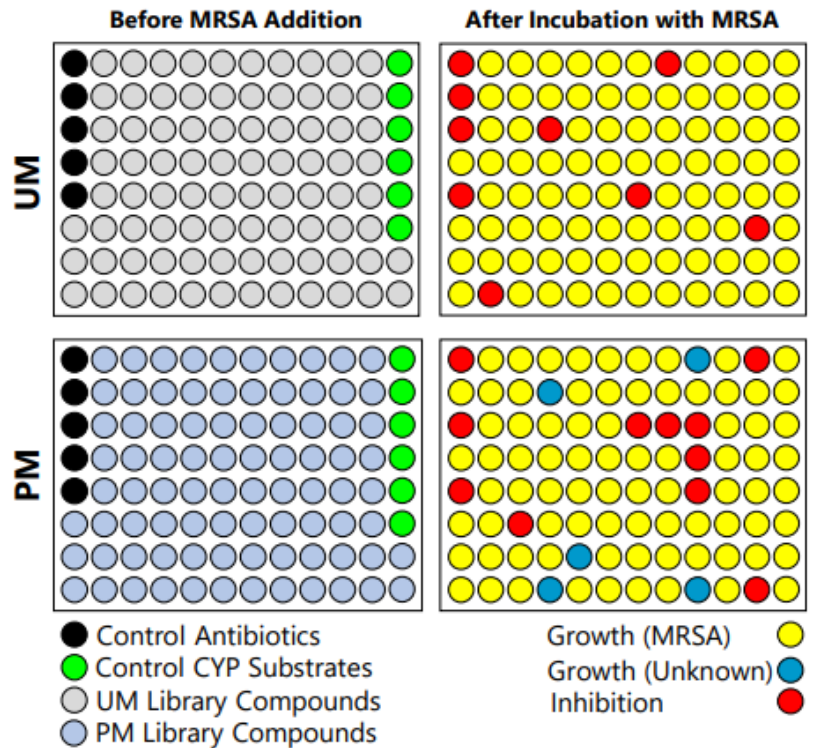
Figure 4. Schematics of observation of contamination in PM library